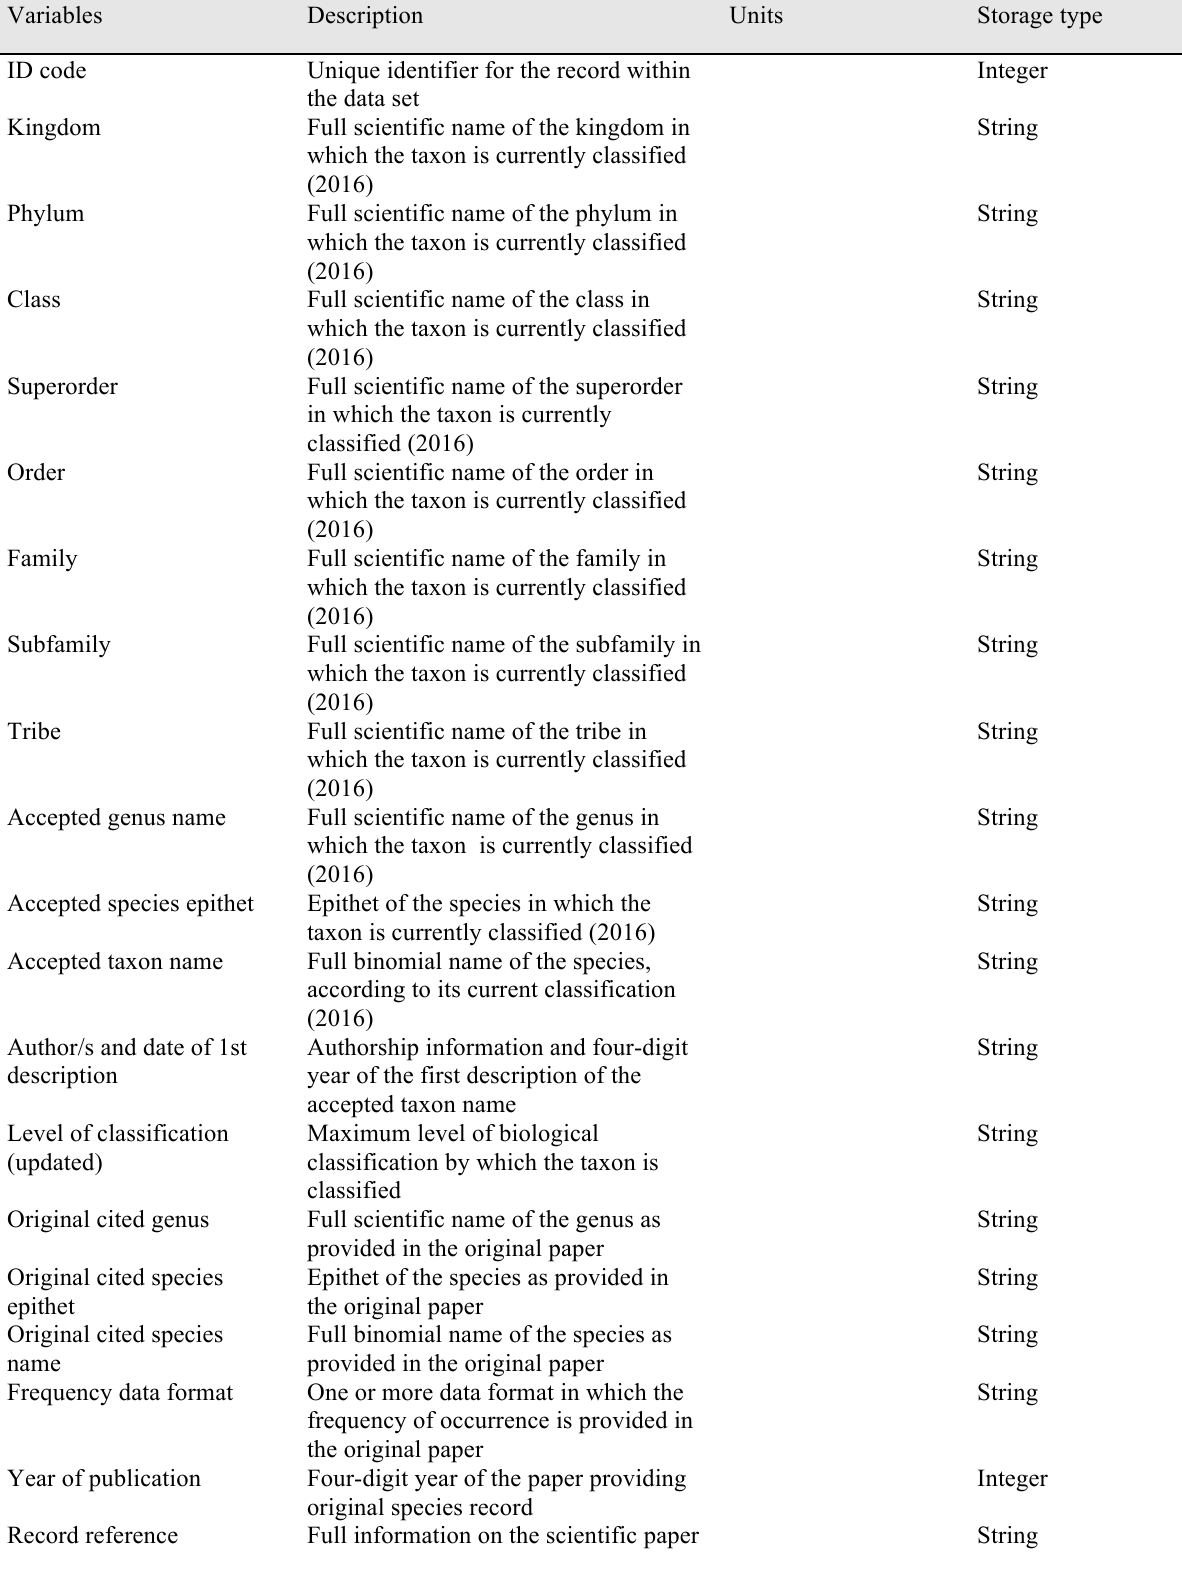
Table 3. Full information linked to the data set with variables, definitions, units and type of storage.